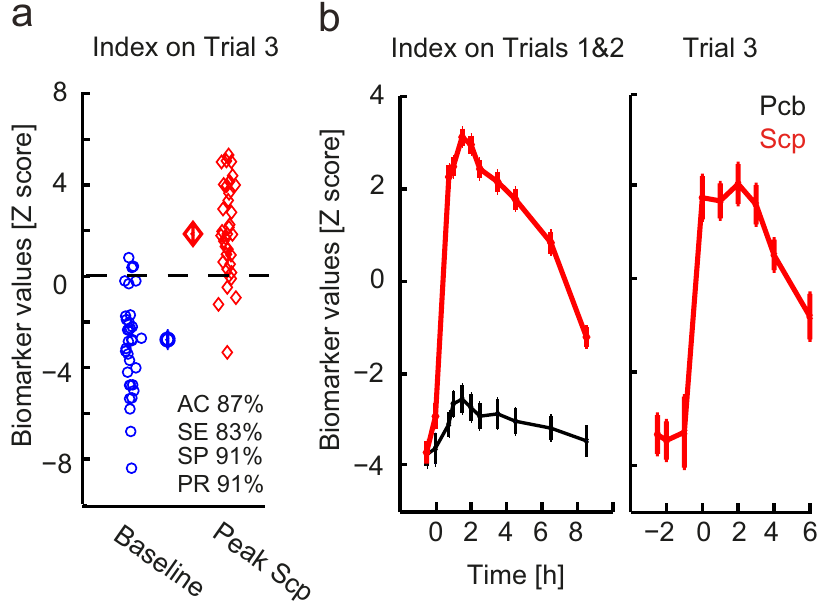
Figure 4. The mAChR index generalizes to a new cohort of subjects. ( a ) The mAChR index also generalizes to a cohort of healthy elderly subjects receiving the same scopolamine intervention (Trial 3), with validation accuracy 87%, sensitivity 83%, specificity 91% and precision 91%. ( b ) Time dependence curves demonstrate the generalizability of the index at all the time points. The mAChR index for placebo ( black ) and scopolamine ( red ) is shown for Trials 1&2 used for developing the index and for independent data from Trial 3 (in the latter there was no placebo condition). The values plotted are group means and standard errors of the mean computed for the within-subject design 67